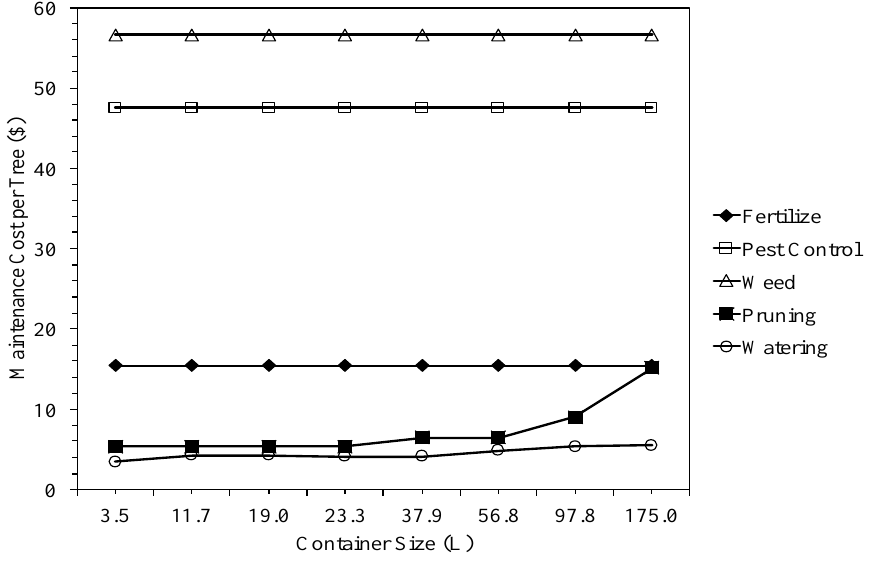
Figure 3. Maintenance costs [US$] per tree for fertilization, pest control, weeding, pruning, and watering of various container sizes summed over a two-year period of growth as determined by RSMeans [23].